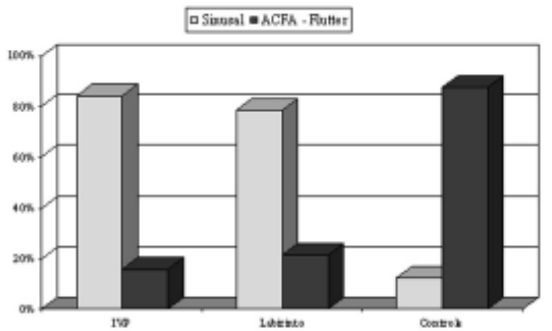
Fig. 1 - Ritmo na alta por